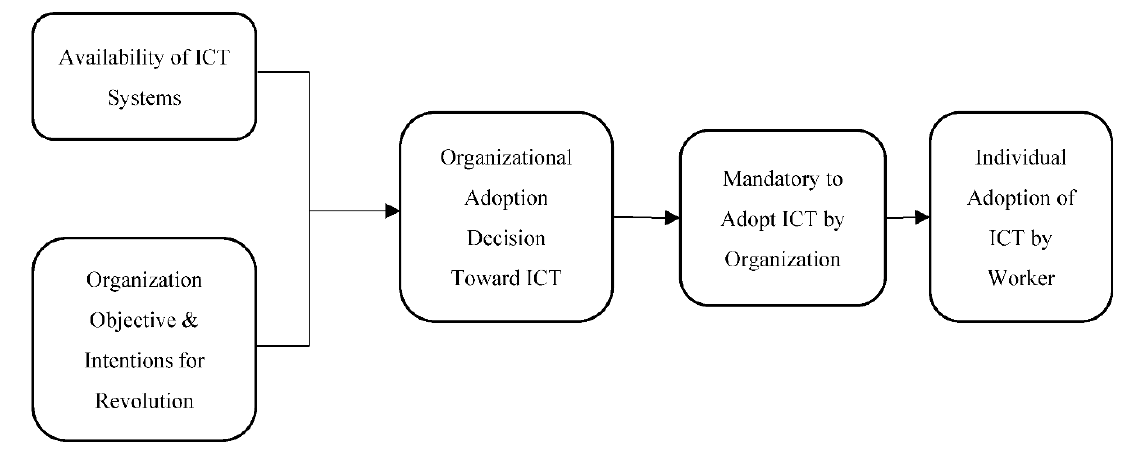
Figure 2. Organization adoption to individual adoption in the construction industry.